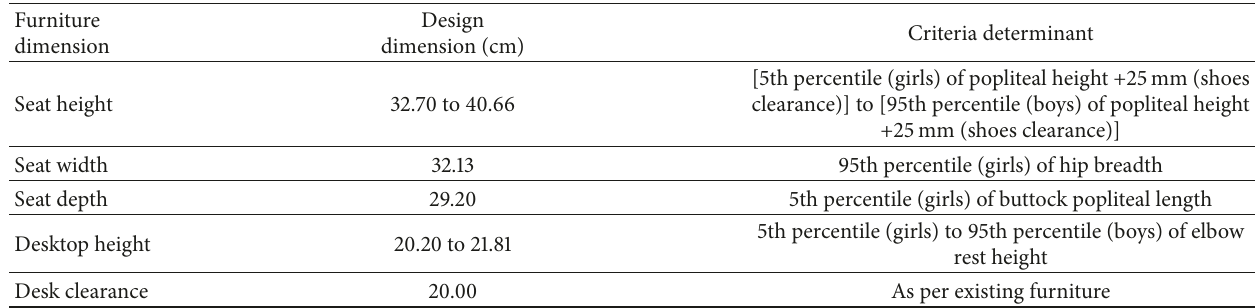
Table 5: Guidelines for designing